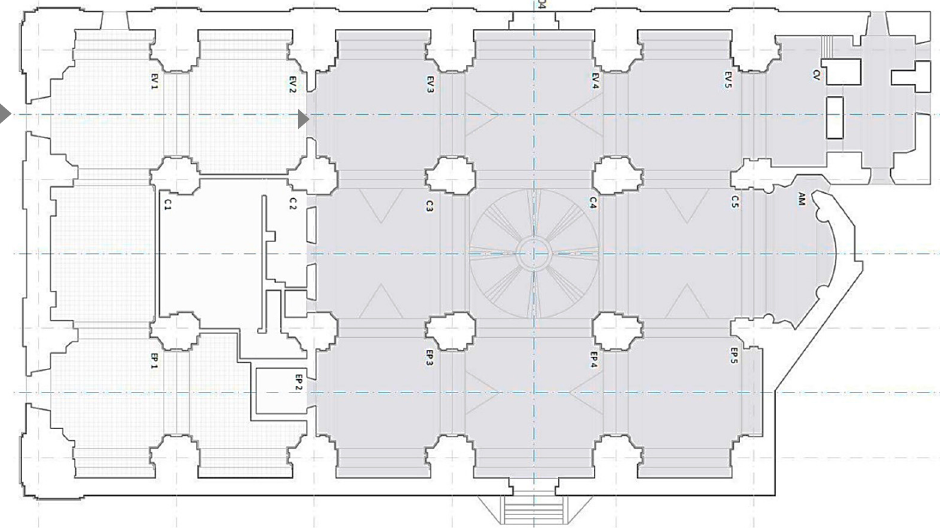
Figure 4. Current Santa Cruz church plan. Light grey: unfinished space. Dark grey: finished and covered space.